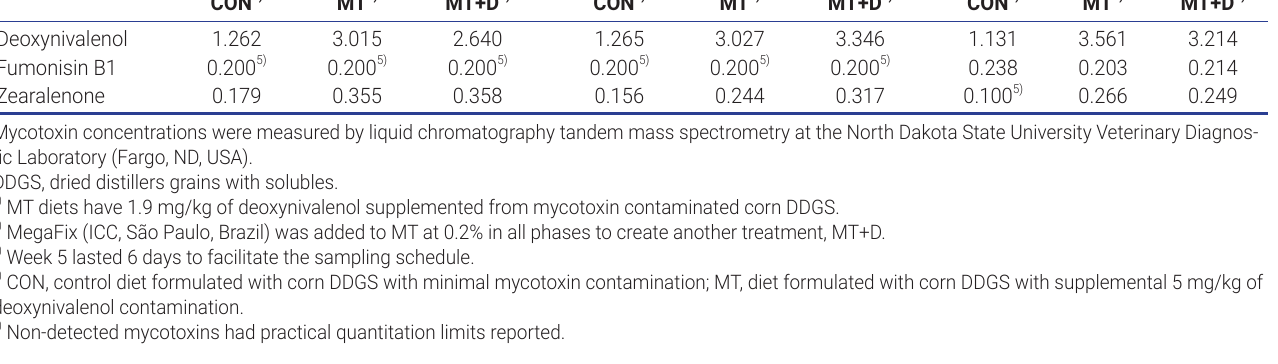
Table 3. Concentrations of detected mycotoxins in experimental diets with (MT 1) ) or without mycotoxins (CON) fed to newly-weaned pigs for 5 weeks on a 3-phase feeding program 2) Mycotoxin (mg/kg of